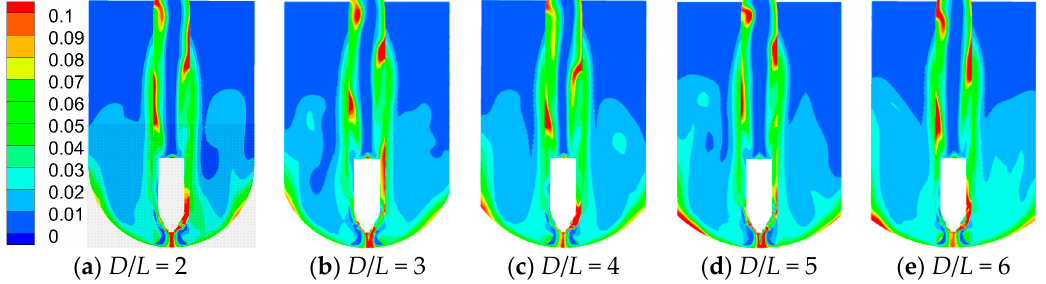
Figure 9. Cross-sectional distributions of the sand volume fraction (View 2). ( a ) D/L = 2; ( b ) D/L = 3; ( c ) D/L = 4; ( d ) D/L = 5; ( e ) D/L = 6.